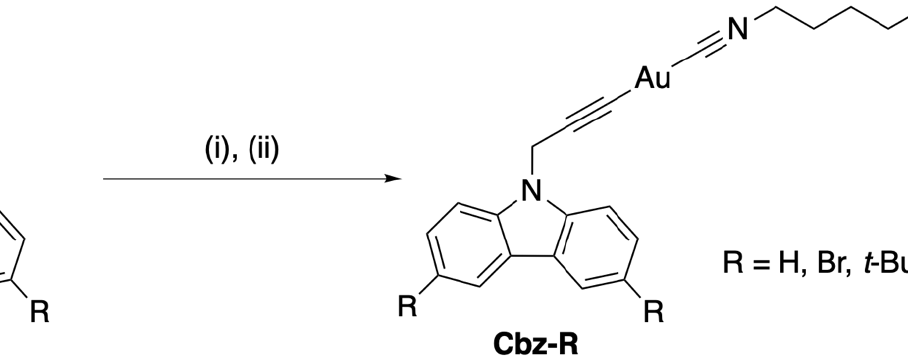
Figure 1. Molecular structure and synthetic route for complex Cbz-R : (i) (tht) AuCl/CH 2 Cl 2 , CH 3 COONa/MeOH; (ii) 1-pentyl isocyanide.